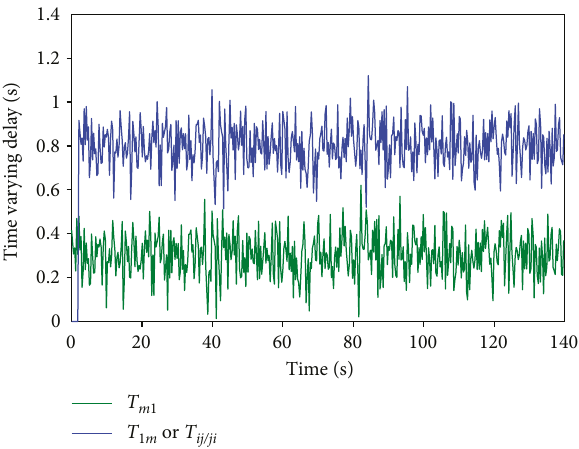
Figure 13: The time-varying delays for the